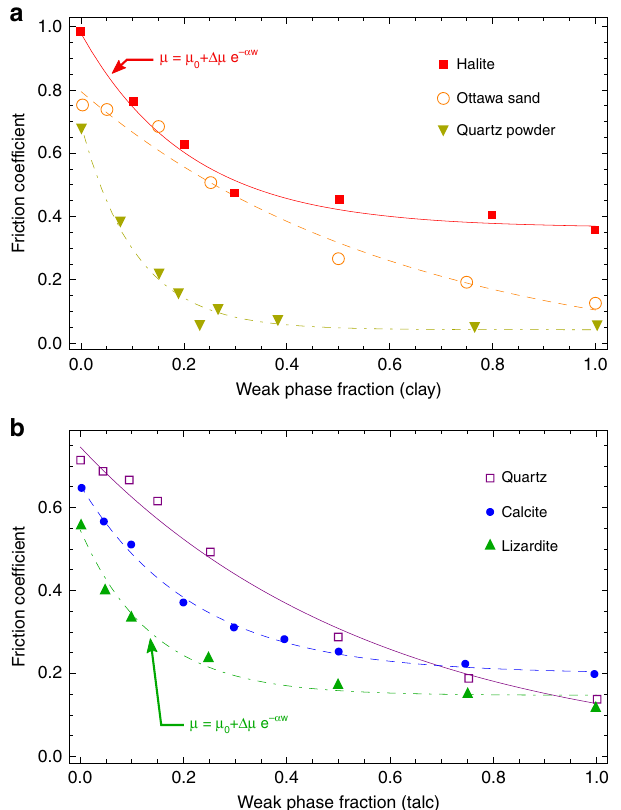
Fig. 1 Effect of a weak phase on the steady state friction coef fi cient. The friction of weak/strong phase binary mixtures is represented as function of the weak phase content in experiments carried out at subseismic sliding velocities and at constant normal stress using triaxial saw cut, double and simple direct shear and rotary shear con fi gurations. a Results for clay as weak phase: red corresponds to a muscovite/halite mixture 47 , orange to a crushed Ottawa sand/montmorillonite mixture 48 , dark yellow to a quartz powder/bentonite mixture 49 . b Results for talc as weak phase: purple corresponds to quartz as strong phase 50 , blue to calcite 51 , green to lizardite 50 . a , b , The points represent the experimental data and the solid or dashed lines represent the interpolation using this exponential